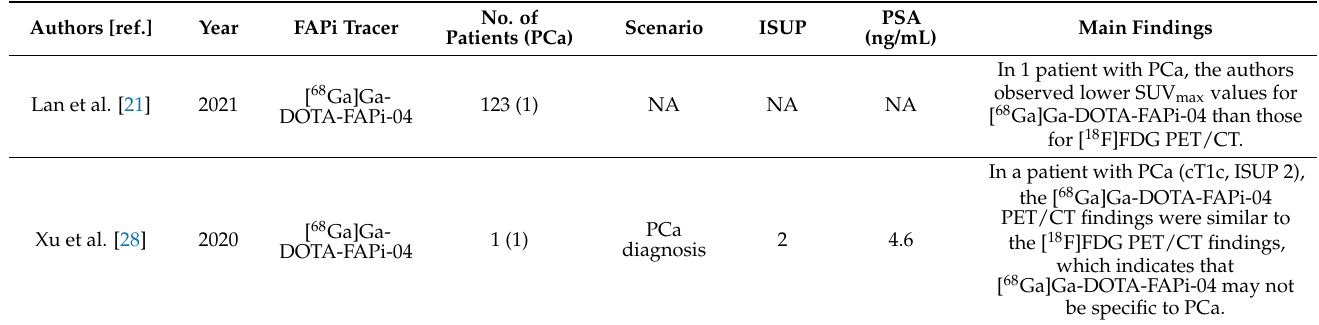
Legend: FAPi, Fibroblast activation protein inhibitor; FDG, fluorodeoxyglucose; ISUP, International Society for Urological Pathology; mPCa, metastatic prostate cancer; NA, not available; PET/CT, positron emission tomography/computed tomography; SUV, standardised uptake value; TBR, tumour-to-background